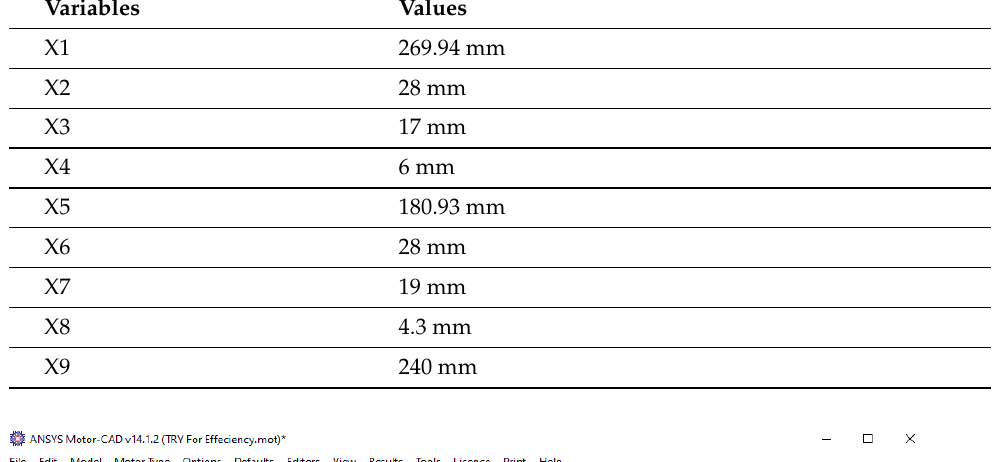
Table 7. PSO Optimized Variables.